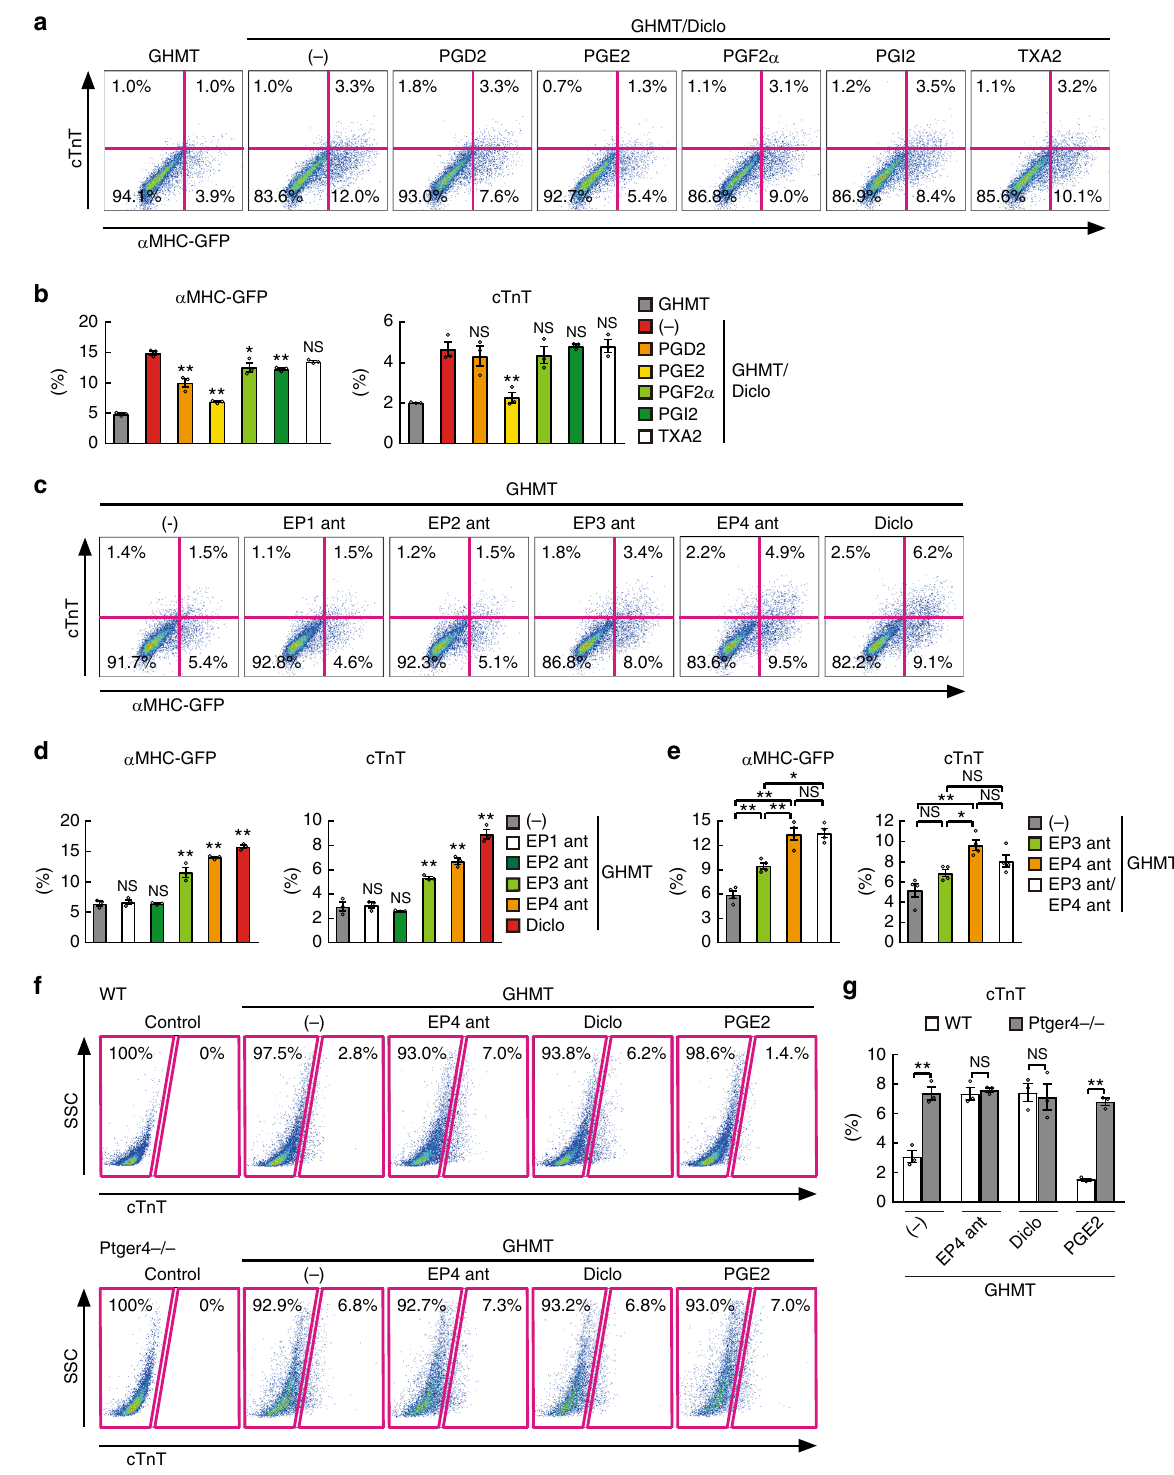
Fig. 4 Diclofenac promotes cardiac reprogramming via inhibition of the PGE2/EP4 pathway. a , b FACS analyses for α MHC-GFP and cTnT expression. Postnatal α MHC-GFP TTFs were transduced with GHMT and cultured with the indicated prostanoids for 1 week. Quantitative data are shown in b ; n = 3 biologically independent experiments. c – e FACS analyses for α MHC-GFP and cTnT expression. GHMT-transduced postnatal TTFs were cultured with the indicated EP antagonists (ant) for 1 week. Quantitative data are shown in d and e ; n = 4 biologically independent experiments. See also Supplementary Figure 3. f , g FACS analysis for cTnT expression in GHMT-treated TTFs from WT or Ptger4 − / − mice with or without EP4 antagonist, diclofenac, or PGE2. Quantitative data are shown in g ; n = 4 biologically independent experiments. Student ’ s t -test was performed for g , one-way ANOVA with Dunnett ’ s post hoc test was performed for b , d , one-way ANOVA with Tukey ’ s post hoc test was performed for e ; all data are presented as mean ±SEM * P < 0.05, ** P < 0.01 vs. the relevant control. NS, not signi fi cant. Diclo,